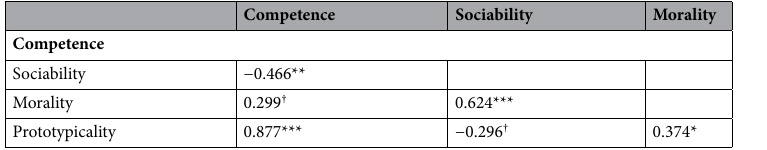
Table 1. To determine the number of clusters based on perceptions of competence, sociability, and morality, we first investigated the plot of within-cluster sums of squares using hierarchical clustering as a partitioning function.